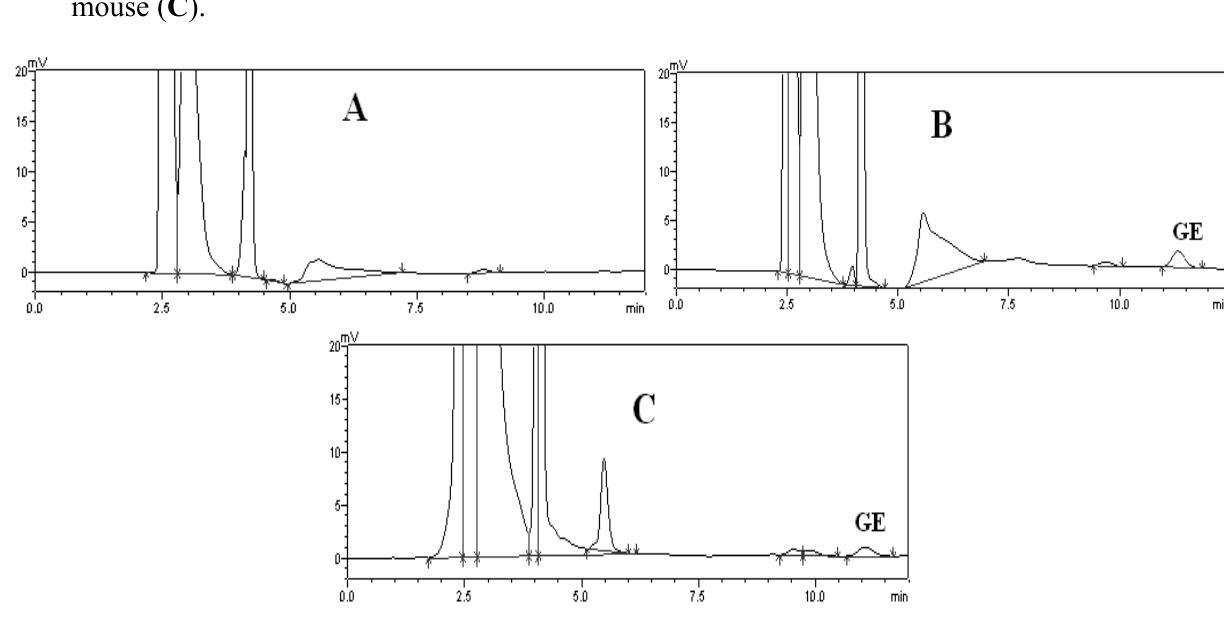
Figure 3. Typical HPLC chromatograms of blank brain homogenate of mouse ( A ); blank brain homogenate of mouse spiked with Ge ( B ); and brain homogenate sample of a dosed mouse ( C ).